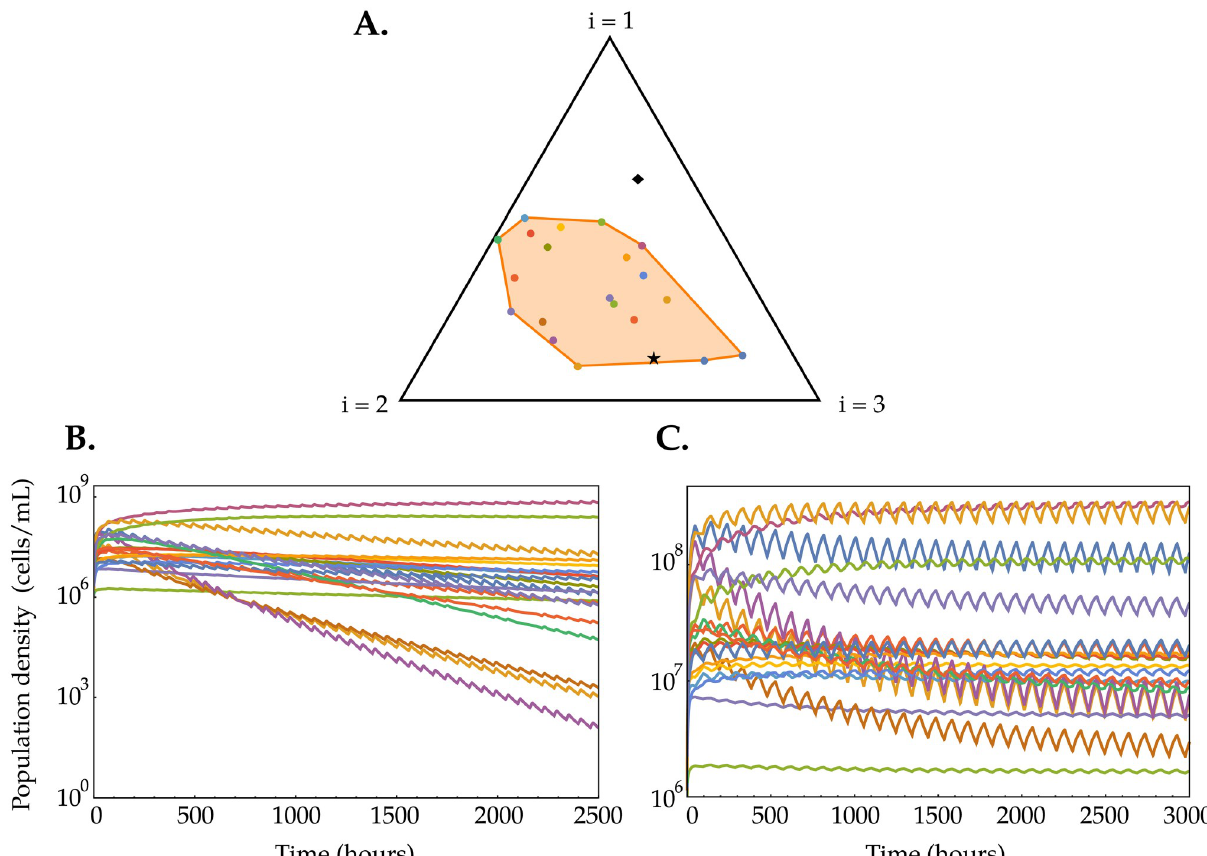
Fig 4. Comparison between the temporal dynamics of species’ population densities (each color represents a different species) in the consumer- resource models with fixed metabolic strategies, when the resource supply rate vector ~ s varies with time. Here, we simulated a system with m = 20 species, p = 3 resources, and with the nutrient supply rate vector switching at regular intervals between the two values shown (black star and diamond) in (A). Specifically, in (B) we made ~ s ð t Þ alternate periodically between ~ s for τ in = 12 h and ~ s for τ out = 48 h, with ~ s chosen within the convex hull of the in out in initial rescaled metabolic strategies and ~ s chosen outside of it (see Figure G in S1 Text for more information on the parameters used). Panel (C) shows out the same quantities, with τ in = τ out = 48 h. See Figure G in S1 Text for the dynamics of the species’ populations in the consumer-resource model with adaptive metabolic strategies.